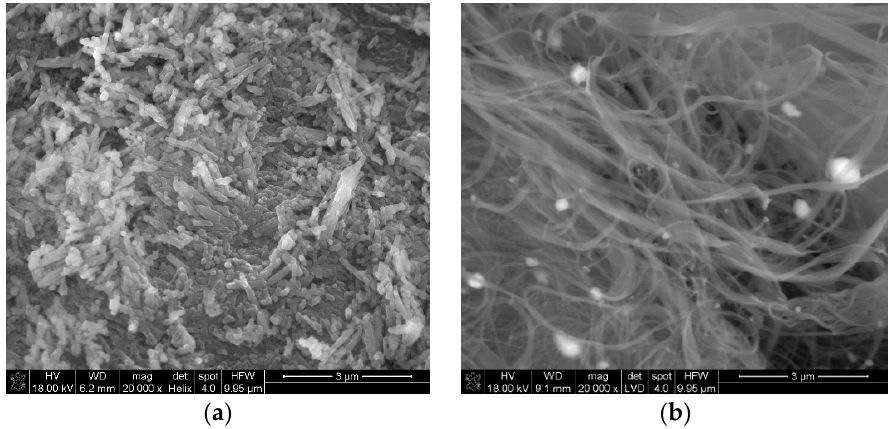
Figure 1. The SEM images of raw halloysite ( a ) and SWCNT ( b ).